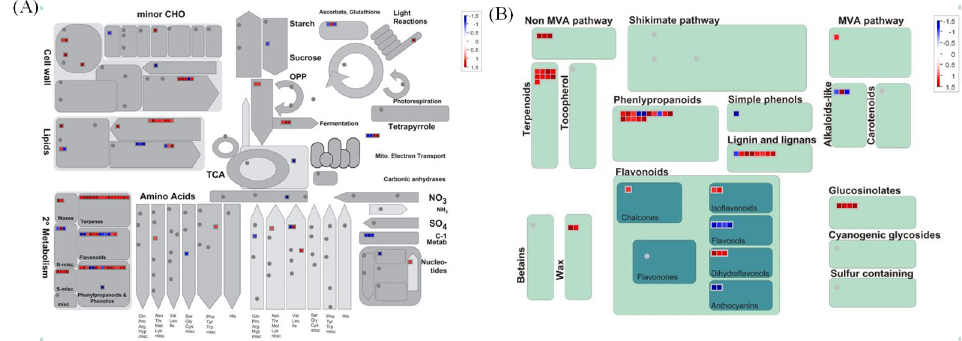
Figure 4. Mapping genes on overview map ( A ) and a secondary metabolism map ( B ) that were differ- entially expressed in nitrate (N-N)-treated in comparison to ammonium (A-N)-treated stevia